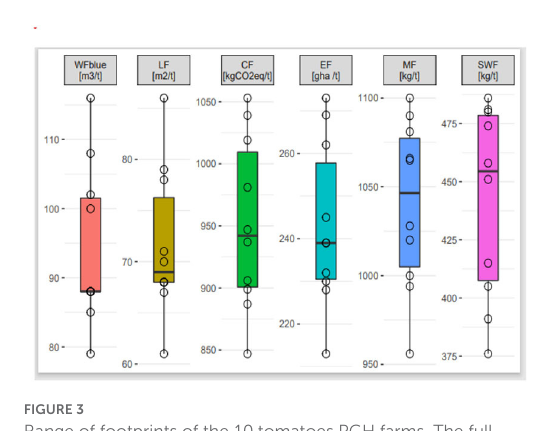
FIGURE3 Range of footprints of the 10 tomatoes PGH farms. The full range of the farms’ footprints values grouped by the footprints indicators. The colored boxes represent the 25th to 75th percentiles of the results, and the vertical lines denote the 95%. The horizontal lines mark the average value of the footprint, and the circles represent the different